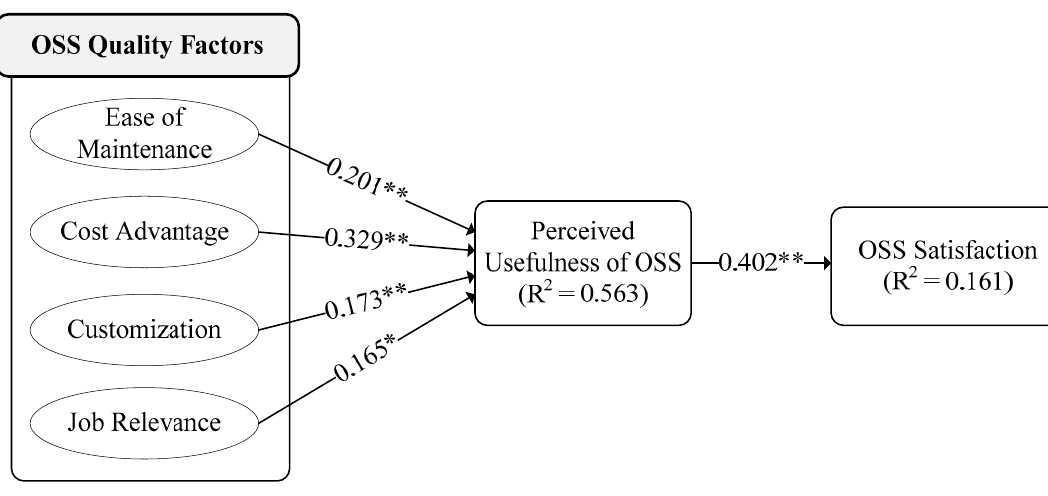
Figure 2. The structural model for males ( n = 176).